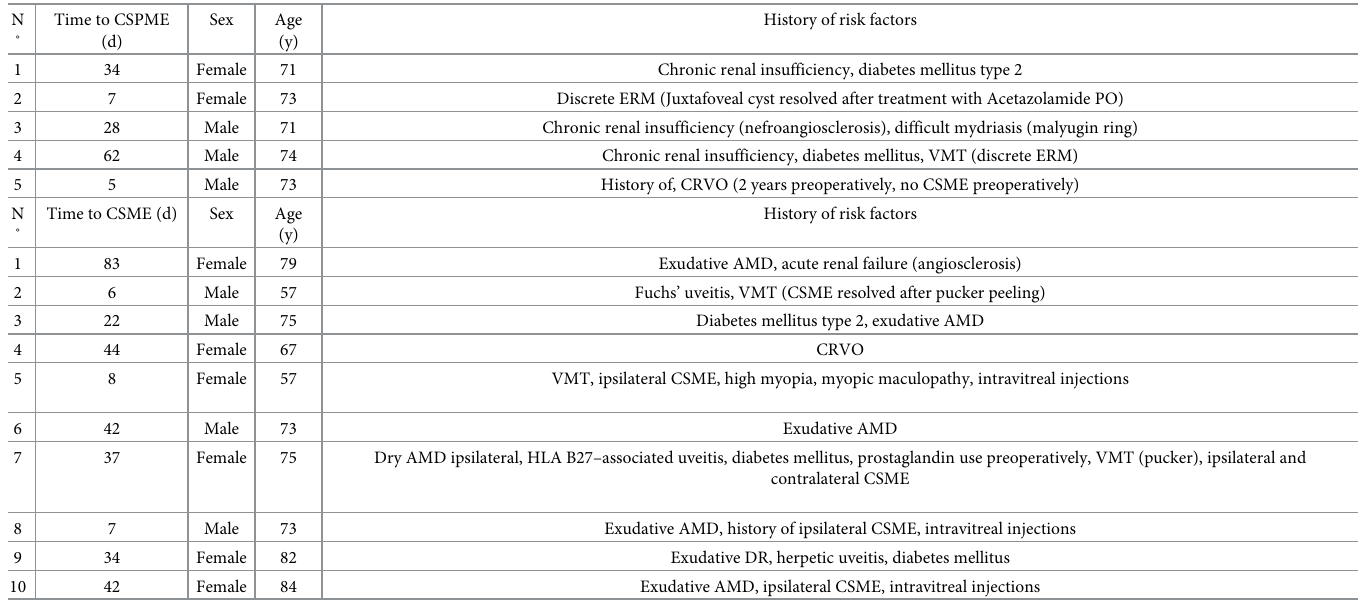
Table 2. a. Patient characteristics of CSPME after the BIL implantation technique. b. Patient characteristics of CSME after the BIL implantation technique.